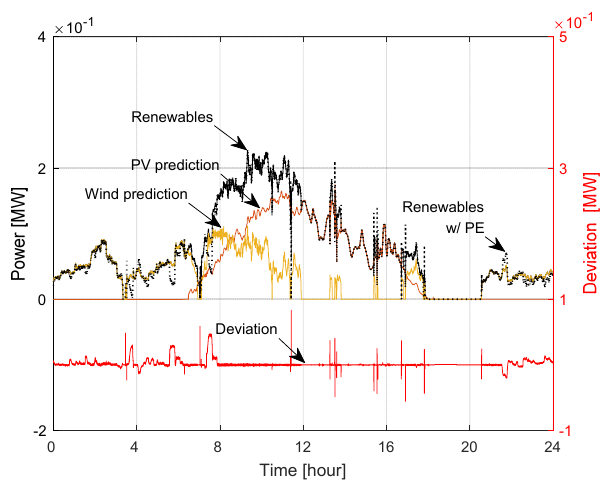
Figure 9. Renewable generation output comparison between two cases.